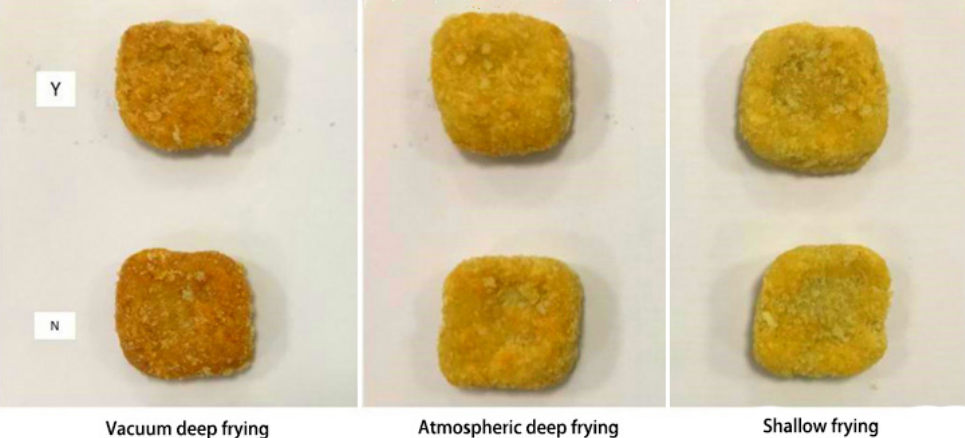
Figure 6. Effect of different frying processes on surimi cubes (Y: Raphanus sativus added; N: no Raphanus sativus ).